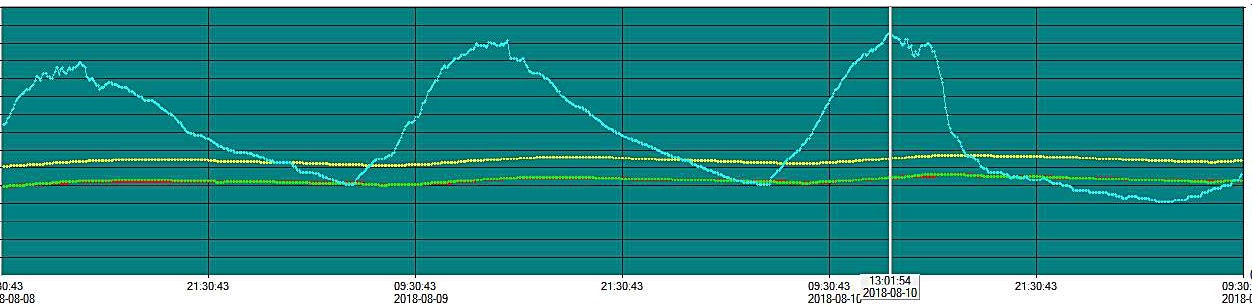
Table 1. Indoor air calculation